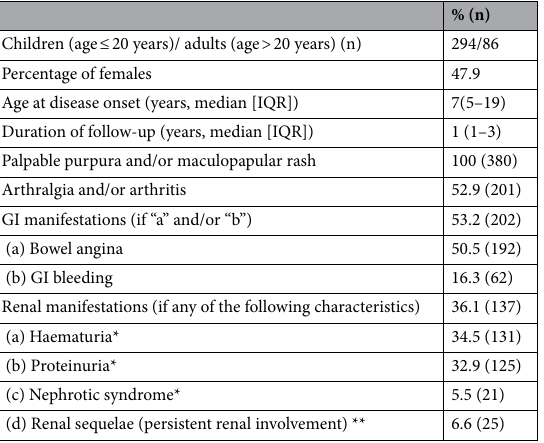
in ankylosing spondylitis 25 and ulcerative colitis 26 , as well as an association of rs13015714 with celiac disease 27 and IBD 21 , and an influence of rs2058660 on the development of Crohn’s disease 28 were previously reported. Genomic deoxyribonucleic acid (DNA) from all the individuals included in the study was extracted from peripheral blood using standard procedures. Patients with IgAV and healthy controls were genotyped for the six polymorphisms mentioned above using predesigned TaqMan 5 ′ single-nucleotide polymorphism genotyping assays (C___2762168_10 for rs3939286, C__31940410_20 for rs7025417, C__29340326_10 for rs7044343, C___2676437_10 for rs2310173, C__31439507_10 for rs13015714 and C__11487892_10 for rs2058660).